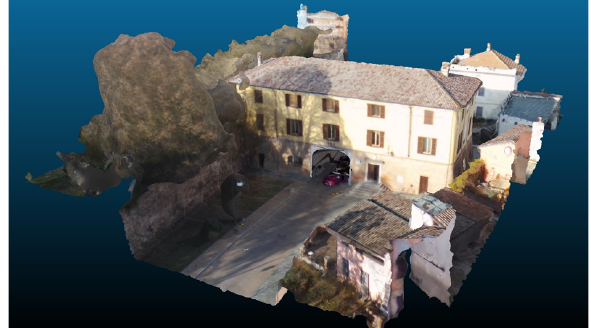
Figure 10. Final 3D mesh.